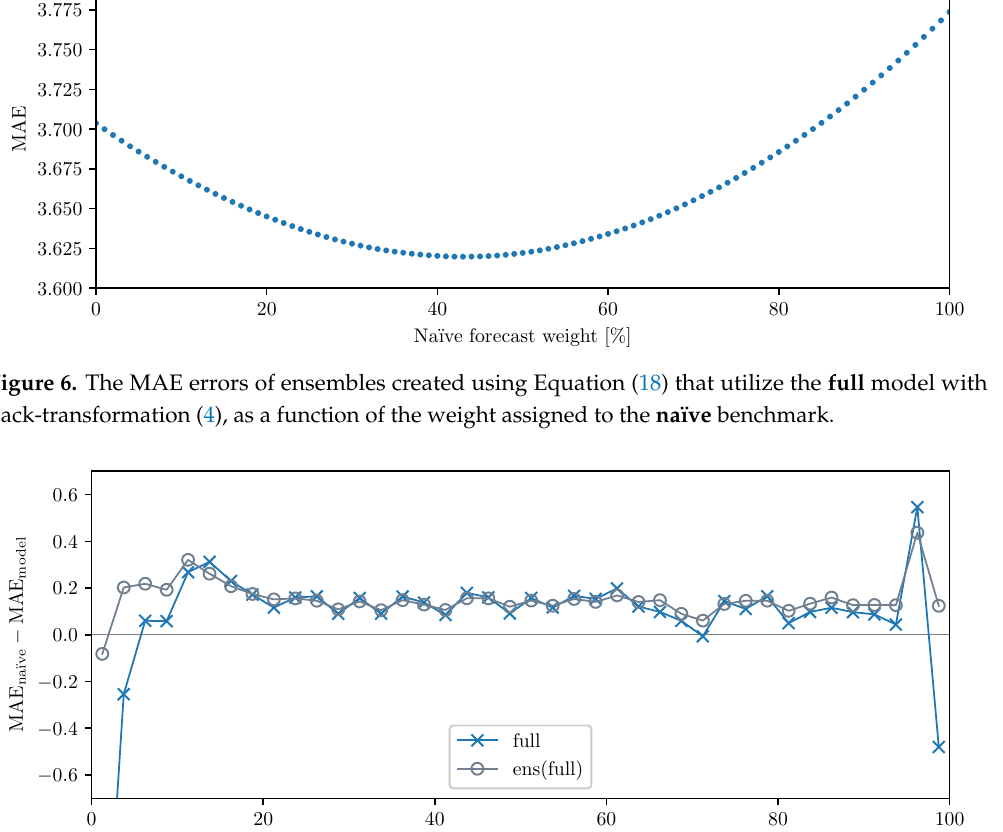
MAE model − MAE full = 1.7 for − −